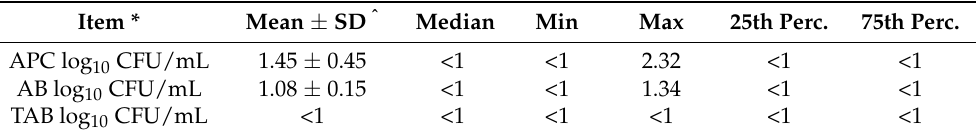
Table 2. Microbiological results and threshold values for sterilized